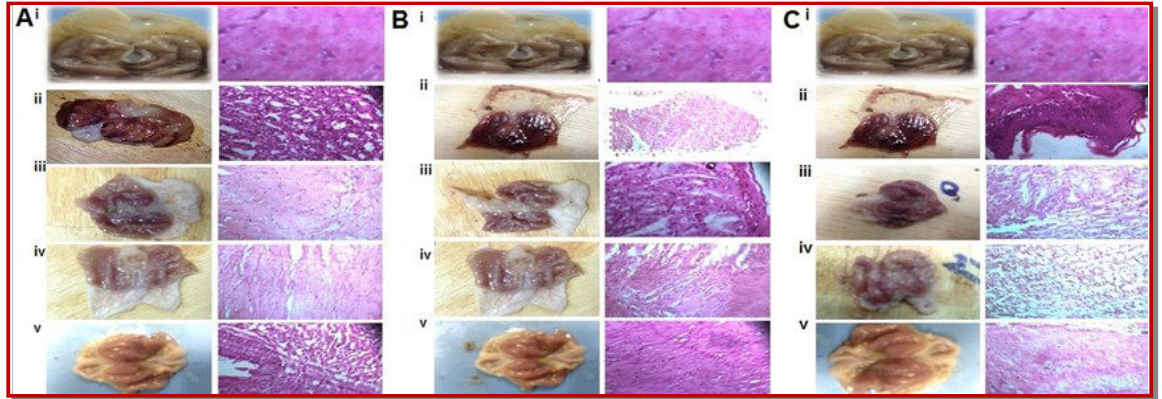
Figure 1: Showing gross view photographic and histopathological images of rat’s stomach in (i) control group, (ii) diseased g roup, (iii) ulcerene (50 mg/kg) (iv) ulcerene (100 mg/kg) and (v) standard drug treated groups in (A) ethanol- (1 mL/200 g), (B) aspirin- (200 mg/kg) and (C) stress-induced ulcerative